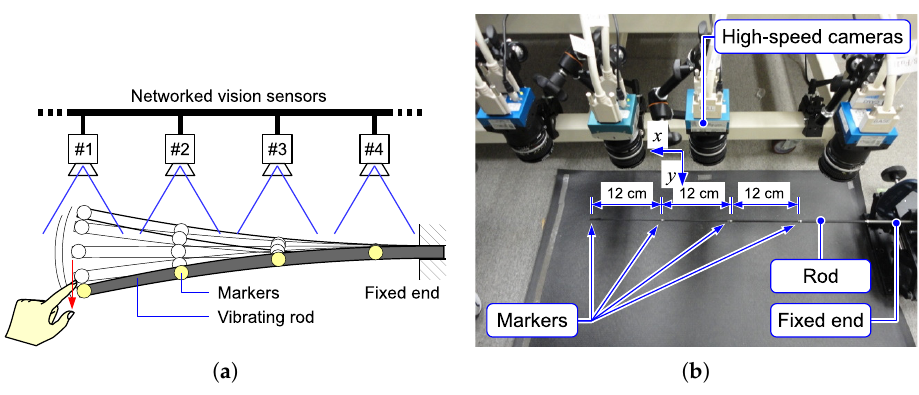
Figure 12. ( a ) Experiment with a vibrating rod. ( b ) Experimental